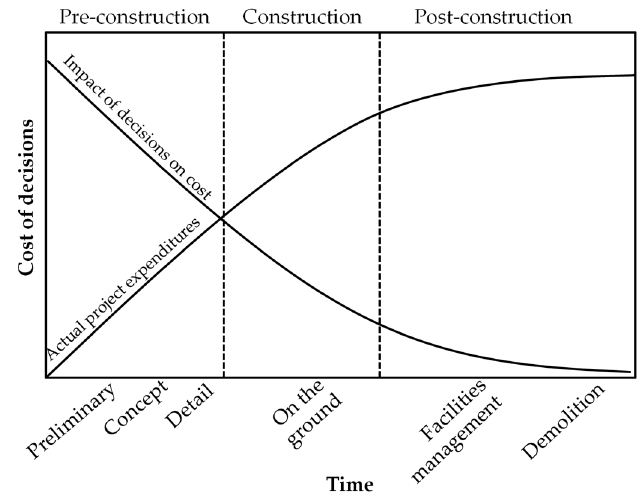
Figure 7. Cost–benefit curve—early decision making in construction life cycle adapted from Reference [63], 2018 American Institute of Steel Construction